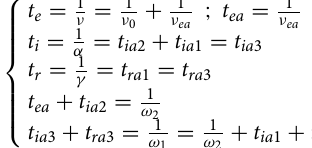
Table 1. The other parameters were calculated using the relations in Eq. (6).